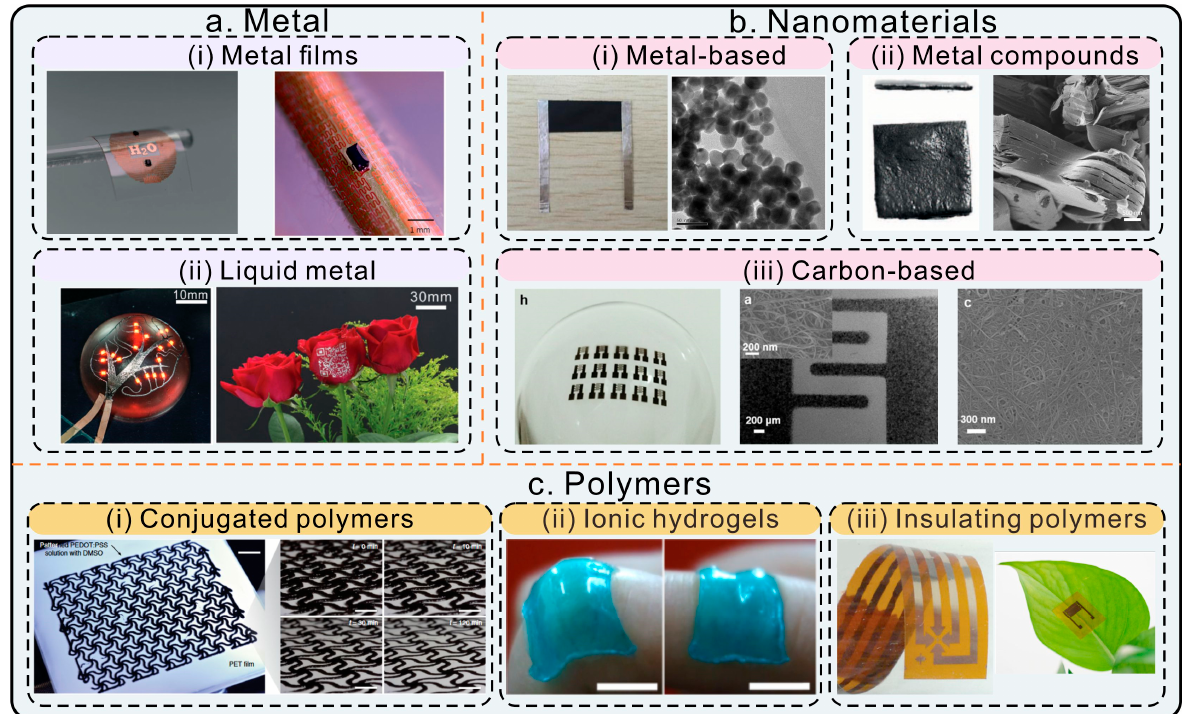
Figure 2. Materials for soft fi lm sensors. ( a ) Metals for fabricating soft fi lm sensors. (i) Metal fi lm-